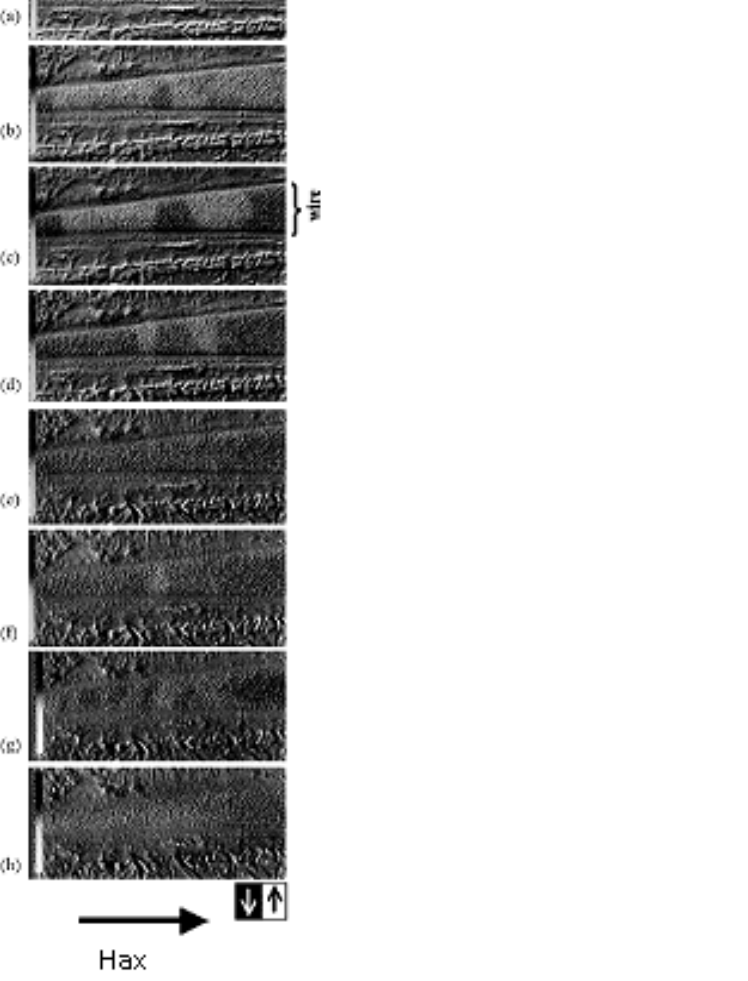
Figure 1. Surface magnetic domain structures transformation in narrow wedge. ( a ) − 10 Oe, ( b ) − 2 Oe, ( c ) − 0.3 Oe, ( d ) 0.03 Oe, ( e ) 0.3 Oe, ( f ) 1.3 Oe, ( g ) 2 Oe, ( h ) 10 Oe. Reprinted with permission from [88].